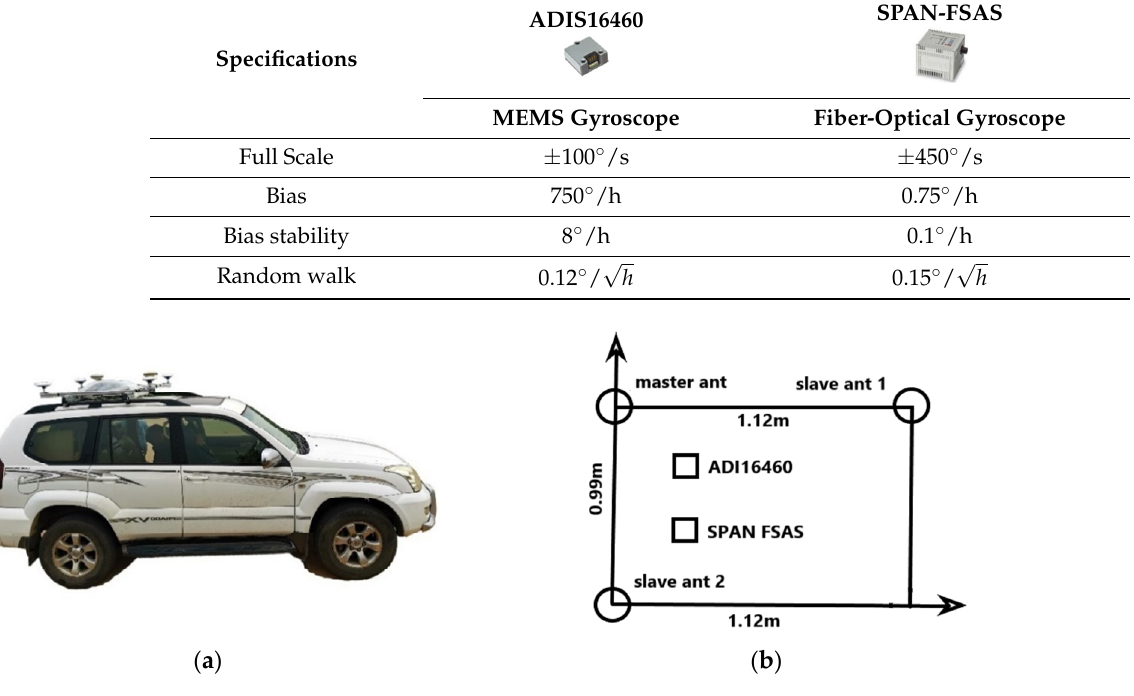
Figure 2. Equipment setup for vehicle experiments: ( a ) the experimental vehicle; ( b ) equipment setup diagram.